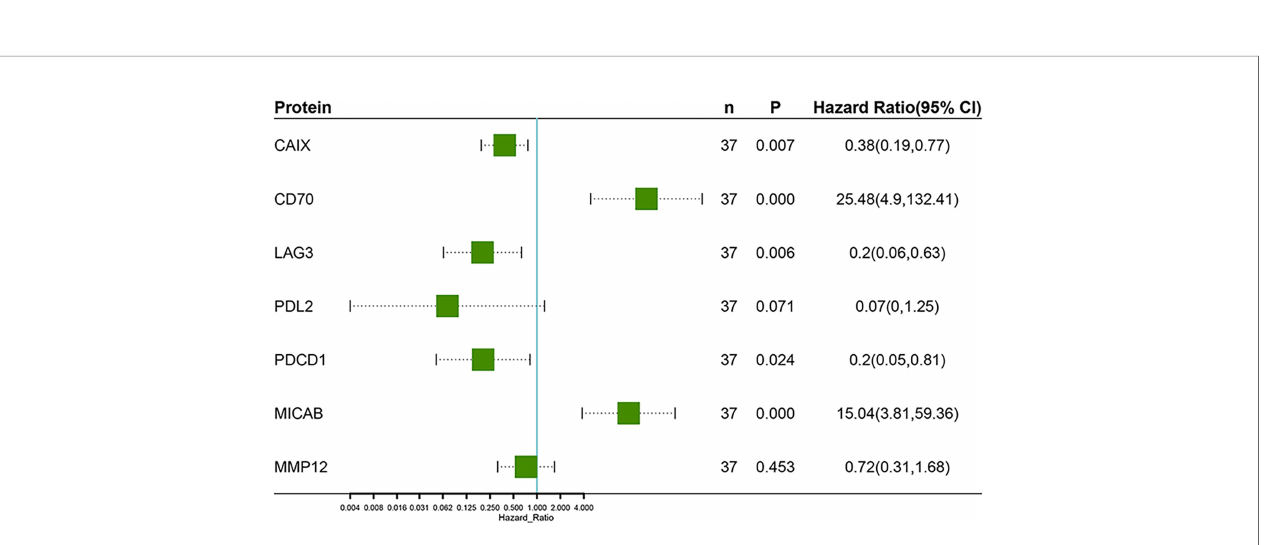
FIGURE 4 | Multivariate Cox regression analysis of progression-free survival based on the changes of 7 proteins after the second treatment cycle.